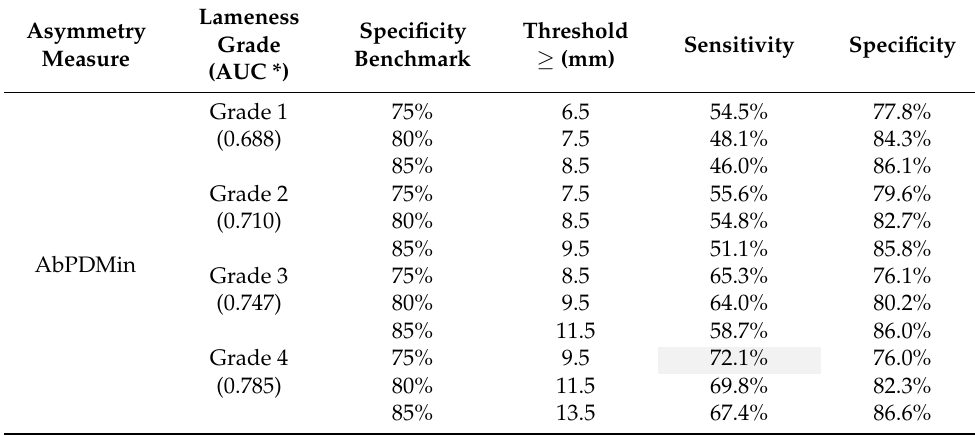
Table 2. Threshold values for identifying horses in the specific lameness grade (or higher) under set minimum specificity benchmarks of 75, 80 and